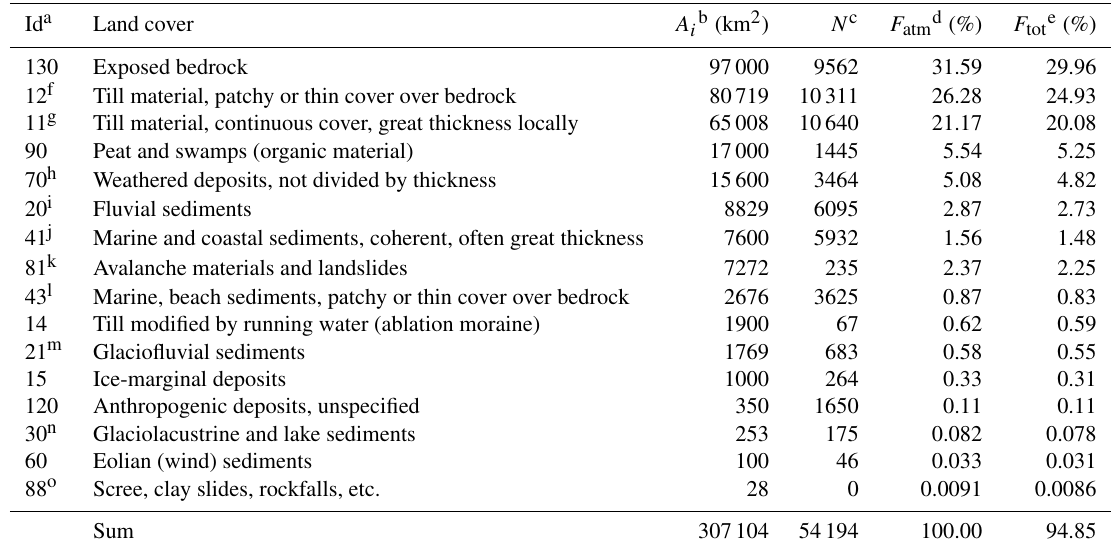
Table 1. Land cover statistics of mainland